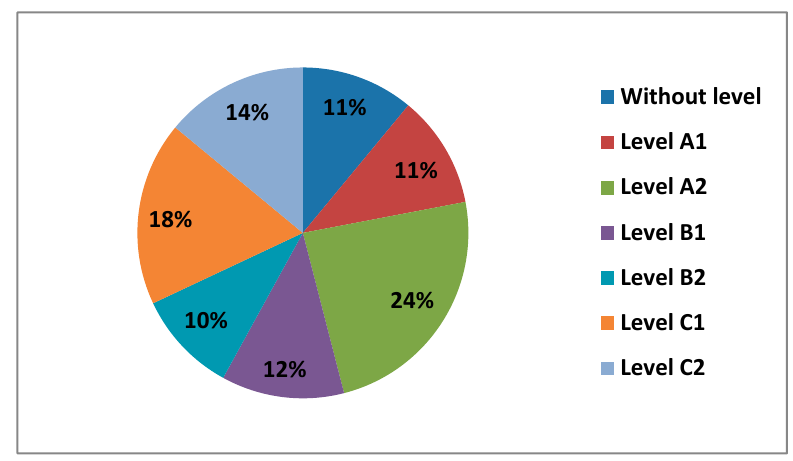
Figure 18. Level of digital competence in teachers in area 3.